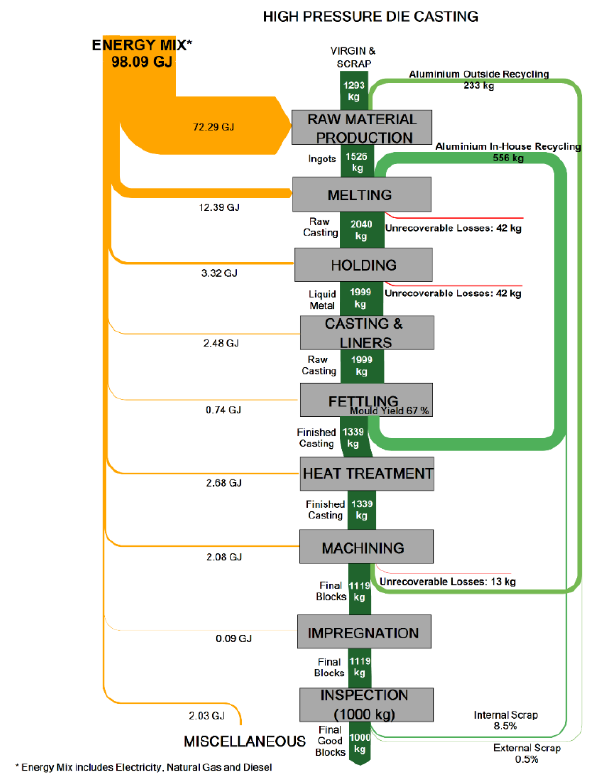
Figure 21. Energy and material flow in high-pressure sand casting (HPDC), showing that 1000 kg of good castings require the melting of 2040 kg of Al and 98.09 GJ.